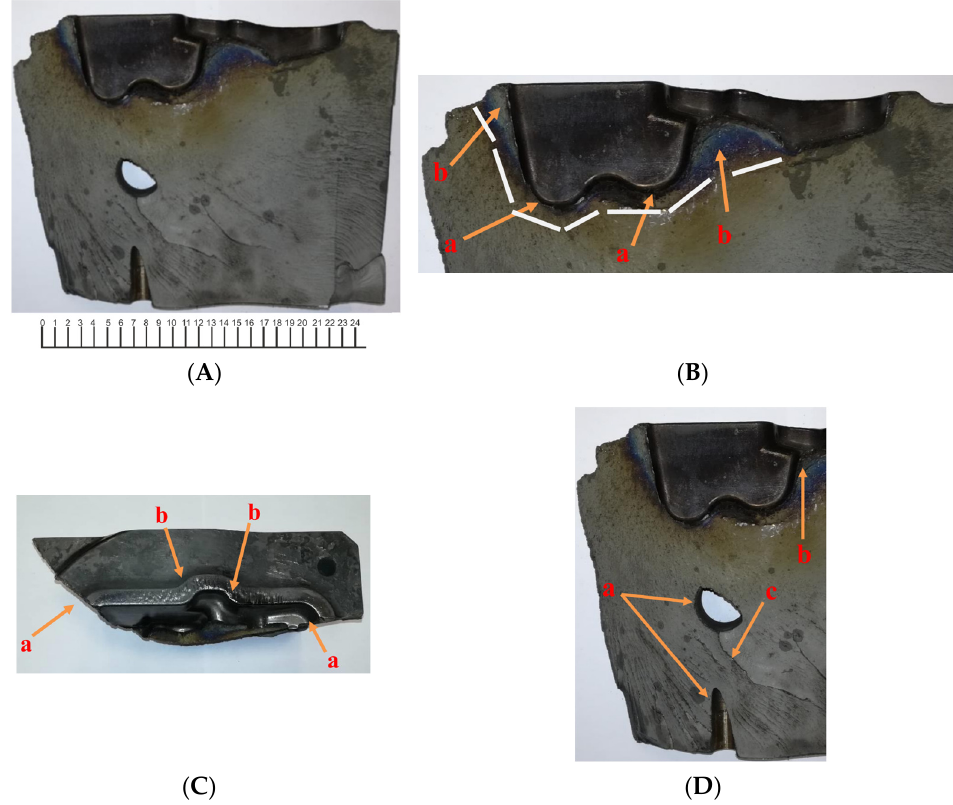
Figure 3. Cracked die insert for forging “fork-type” forgings: ( A ) view of the fracture surface, ( B ) the fracture with the deepest areas of the die insert cavity (marked “a”) and the extent of heat influence deep into the die insert (blue fracture surface, marked “b”); white line indicates the range of fracture surface oxidation during tool operation before its destruction, ( C ) with the locations of the intersection of the crack with the flash (marked “a”) and the wear marks on the flash bridge (marked “b”), ( D ) with the location of the holes for fixing the forging dies (marked “a”), the area of fatigue cracking (marked “b”), and the area of material “final fracture” (marked “c”).